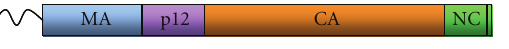
Figure 5: MLV Gag protein. The MLV Gag protein is modified at its N-terminus by the 14-carbon fatty acid myristic acid. It is cleaved during virus maturation into MA, p12, CA, and NC; most of the NC molecules are also cleaved 4 residues before their